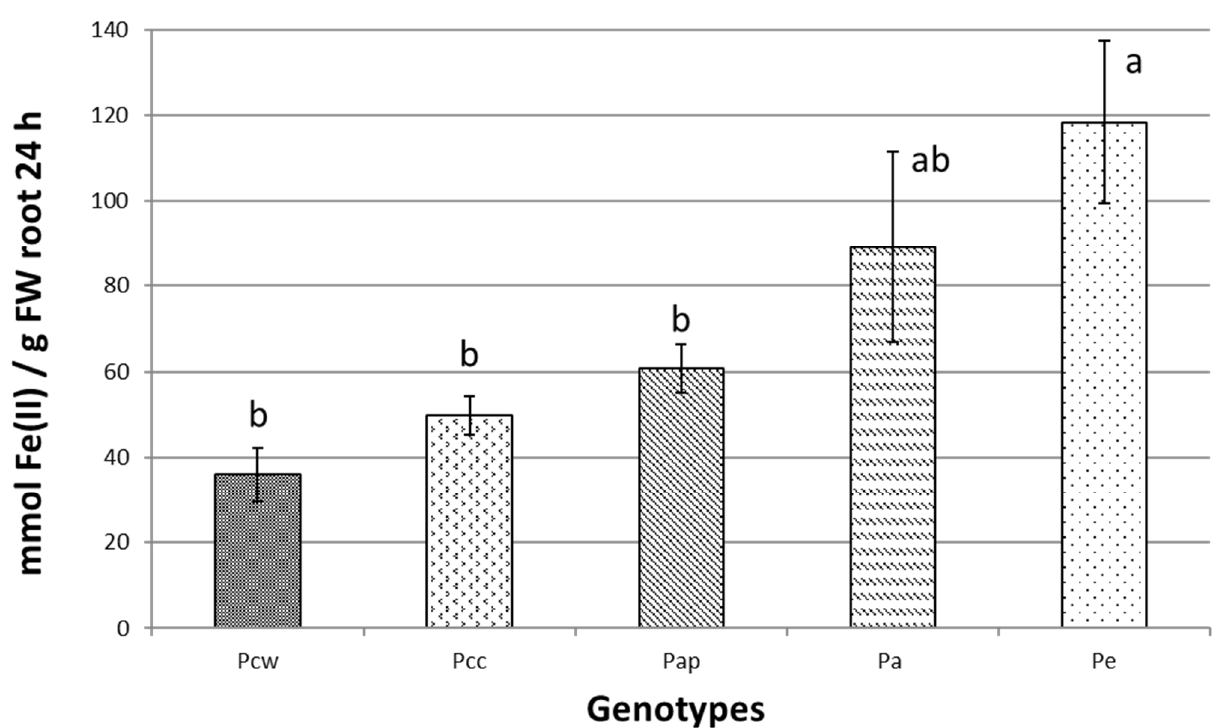
Figure 7. Average iron reduction capacity of roots of plantlets belonging to four interspecific Pyrus hybrids (Pa, Pap, Pcc, Pe) and open pollinated Pyrus communis ‘Williams’ (Pcw) under in vitro iron deficiency conditions. Since no significant interaction was observed between NaHCO 3 and Pyrus species ( p = 0.361), mean values come from the measures of 32 replicates per genotype. Bars represent the standard error. Hybrids with different letter are significantly different (Tukey, p < 0.05).